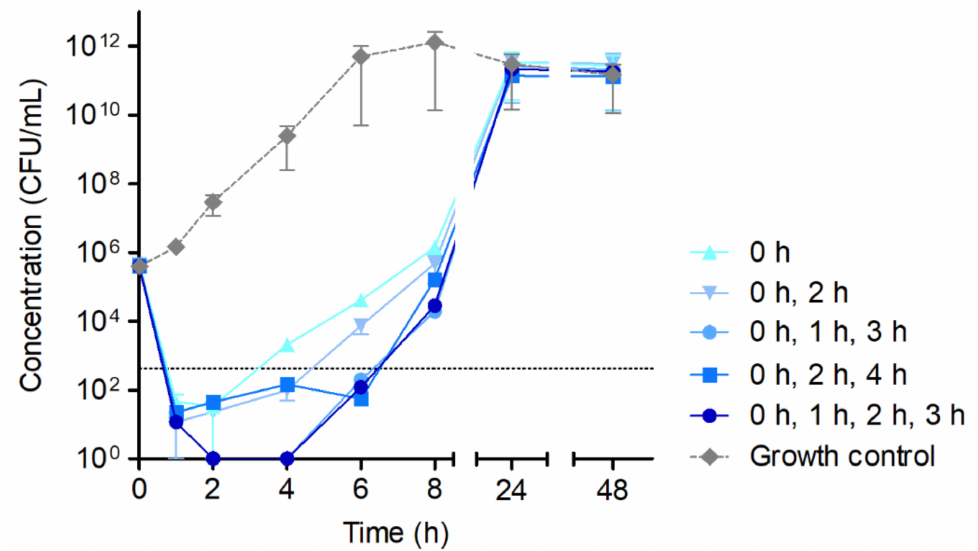
Figure 2. Time–kill curves of the 16-fold MIC of HY-133 applied at multiple time points against S. aureus strain ATCC 29213. Plot shows mean values for log 10 of the numbers of CFU/mL versus time. The threshold (dotted line) implicates the ≥ 3 − log 10 decrease in CFU/mL. Time–kill curves were performed in triplicate (mean ± standard deviation). A culture of S. aureus strain ATCC 29213 without HY-133 was always included as a growth control (dashed line). The times given in the legend show the time points of HY-133